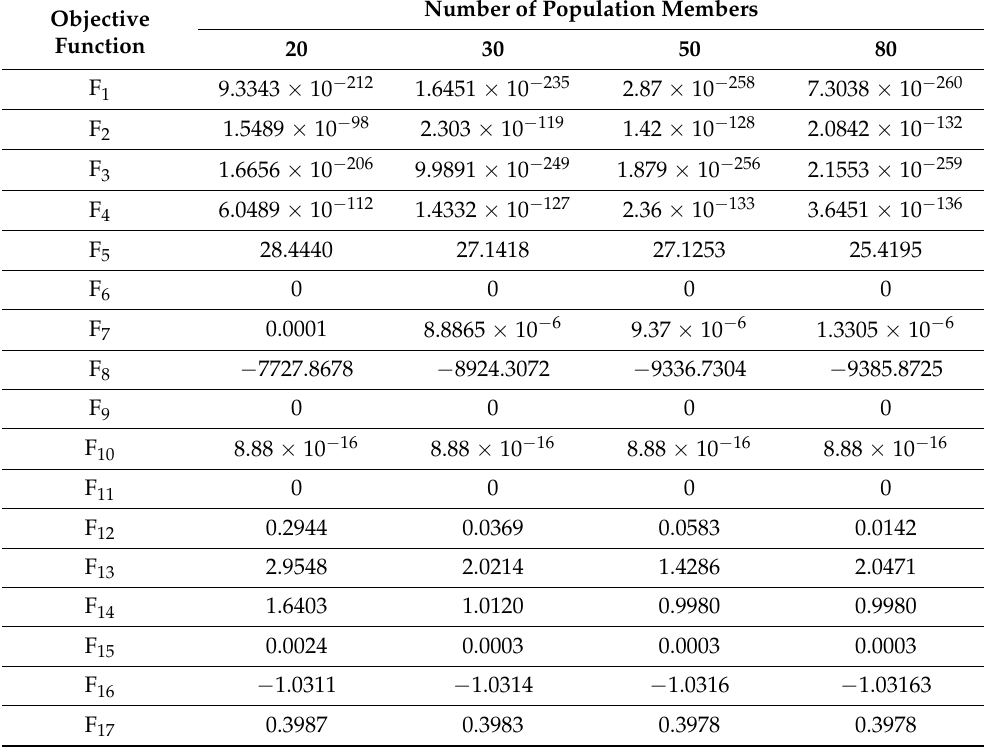
Table 6. Sensitivity analysis of the POA to N